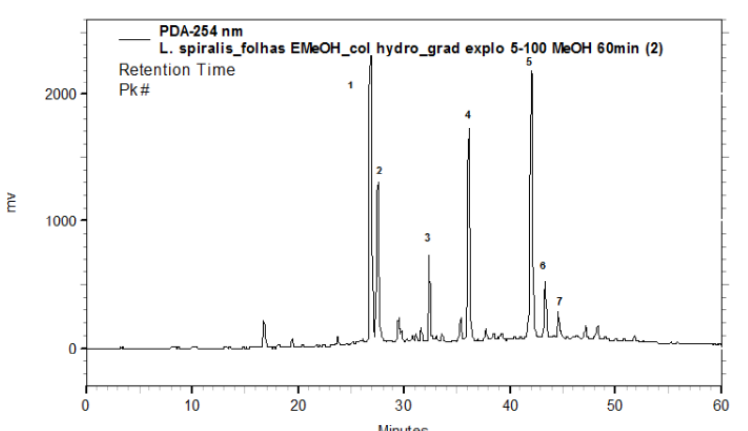
Figure 2. UV spectra of the chromatographic (HPLC) data of the methanolic extract of leaves from L. spiralis (peaks 1–7). Conditions: Phenomenex Synergi Hydro RP18 (250 × 4.6 mm i.d.; 4 μ m) equipped with a Phenomenex security guard column (4.0 × 2.0 mm i.d.). The mobile phase composition was methanol. The gradient